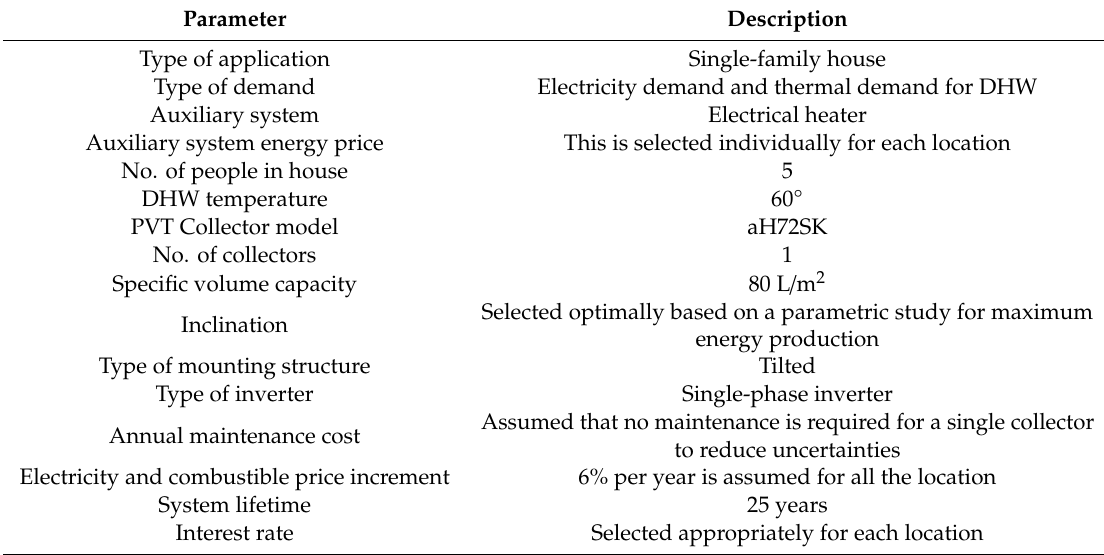
Table 3. Boundary conditions for the simulation